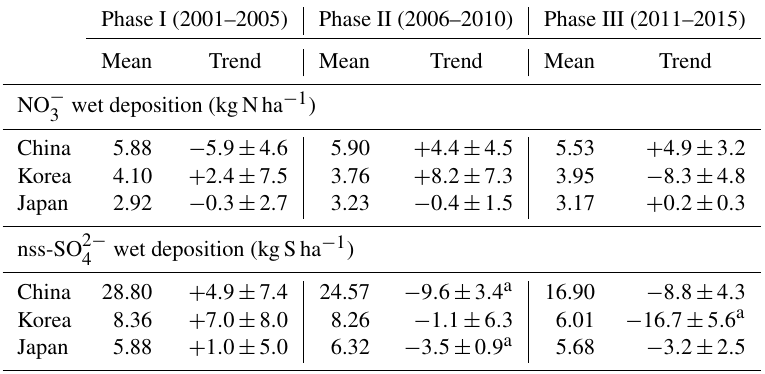
Table 4. Statistical analysis of average values and linear trends for NO − phases I, II, and